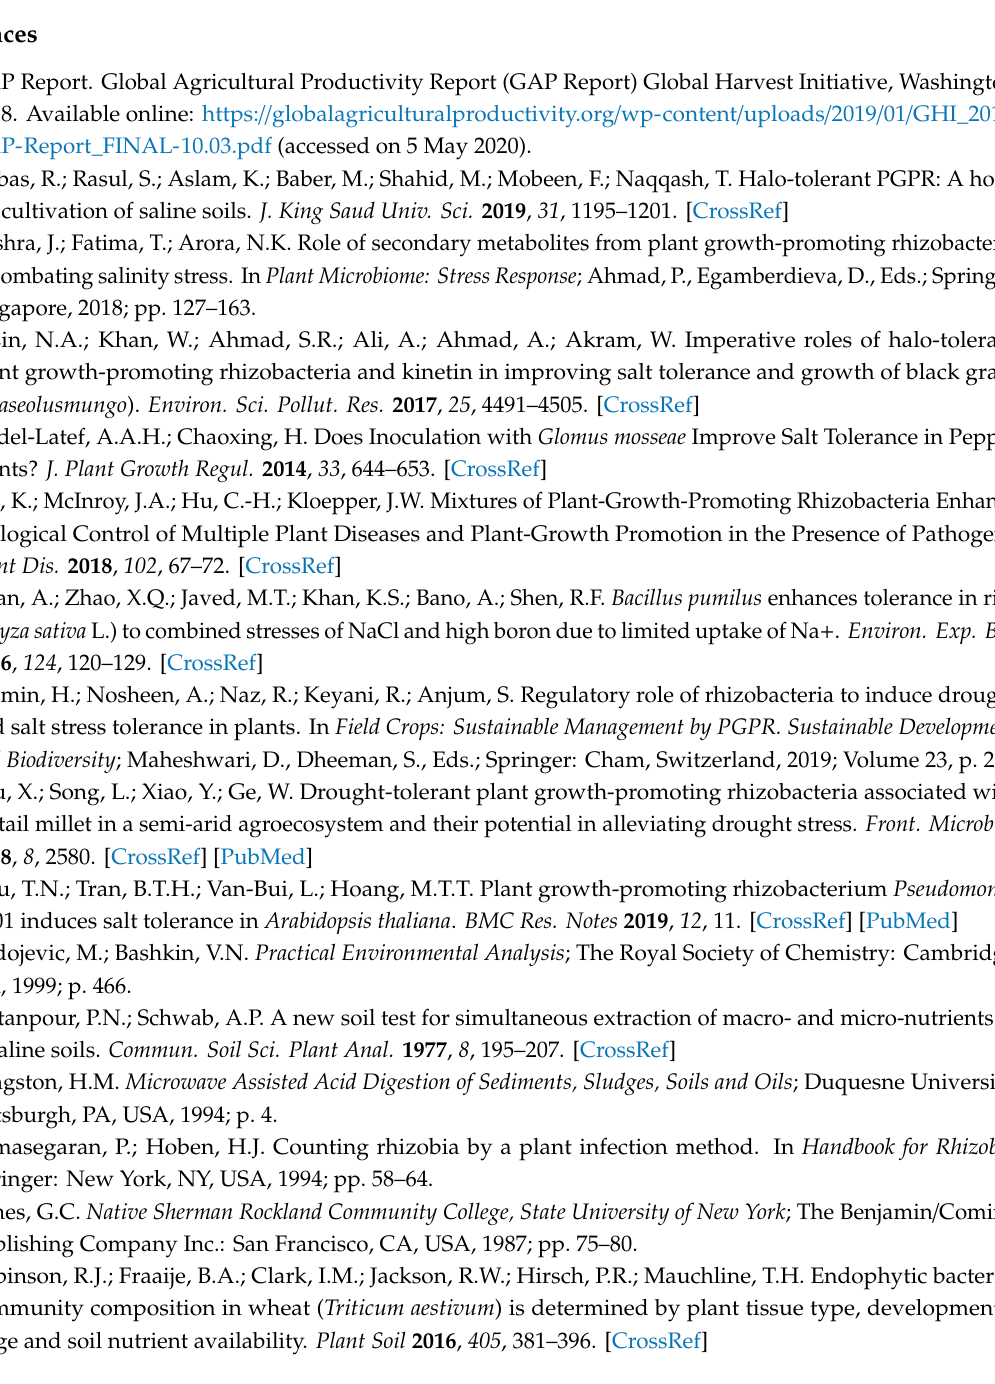
determined by QTS -24 kits, Figure S1: Phylogenetic analysis of strain SR1, Figure S2: Phylogenetic analysis of strain SR2, Figure S3: Phylogenetic analysis of strain SR3, Figure S4: Phylogenetic analysis of strain